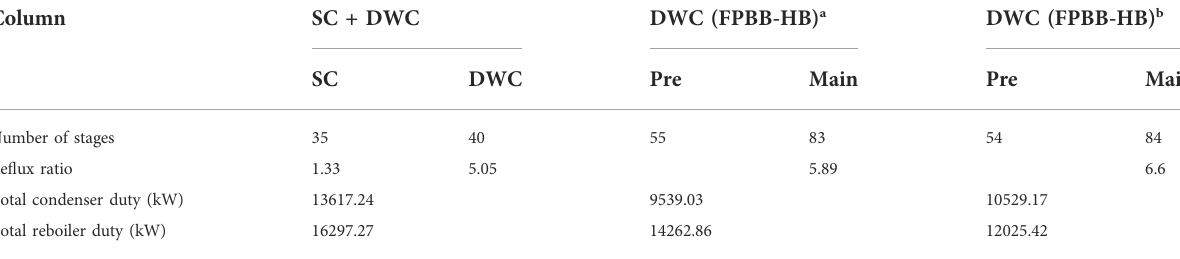
TABLE 8 Optimal design for Example 3.